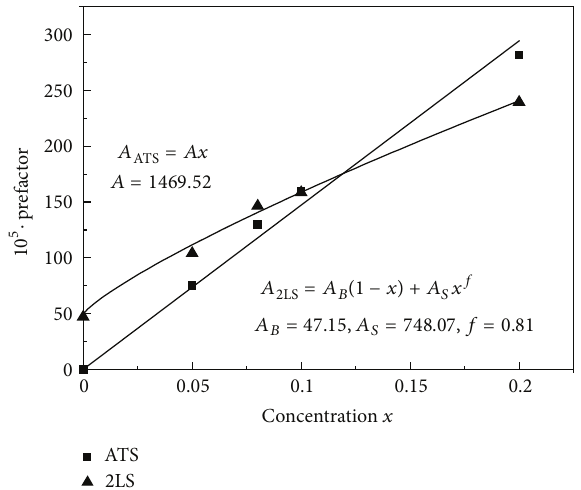
Figure 10: The 2LS and ATS dimensionless prefactor parameters ( ×10 5 ) for all glasses (from Table 1) as a function of 𝑥 . Our data fit well with our theoretical expectations (full